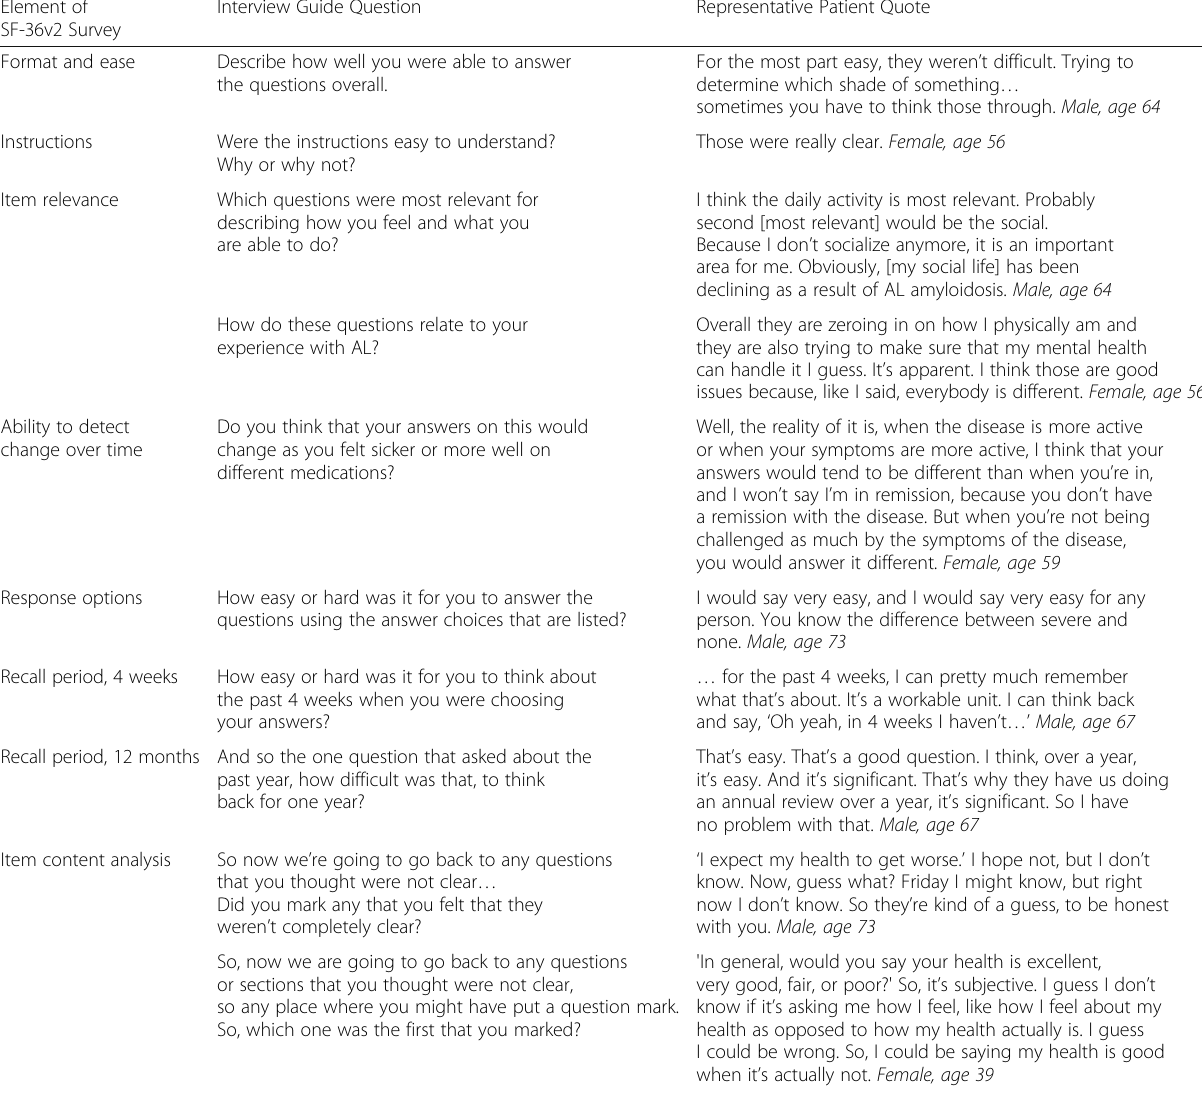
Table 4 Patient quotes from cognitive debriefing interviews Element of SF-36v2 Survey